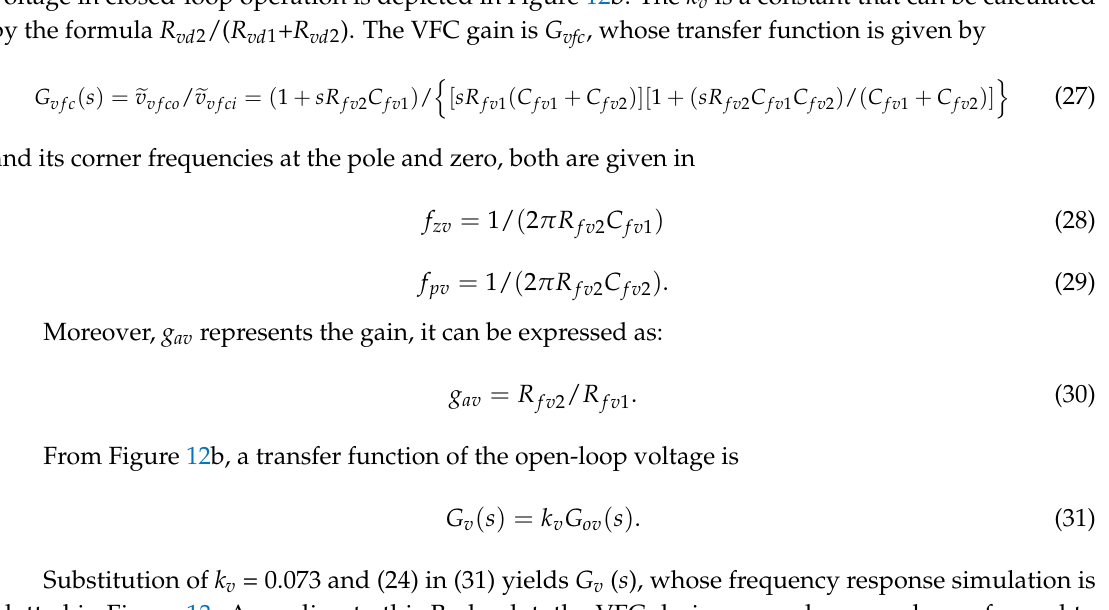
Figure 11. Bode plot simulation: G oc ( s ).